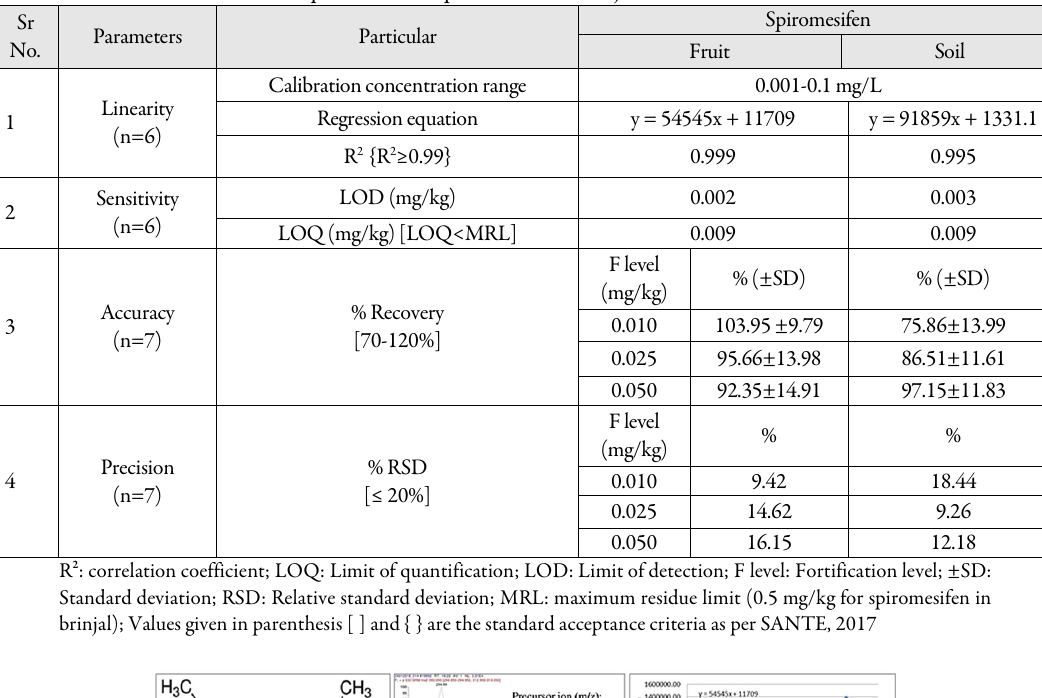
Table 1. Method validation parameters of spiromesifen in brinjal fruit and soil